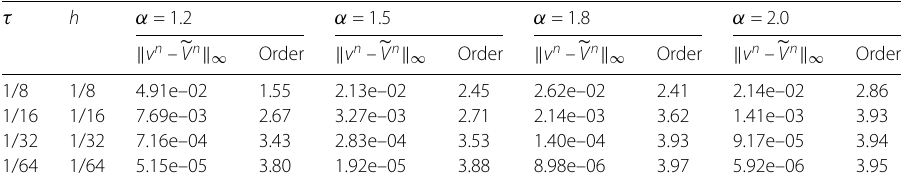
Table 4 L ∞ -norm errors and convergence orders of (cid:24) V obtained by the fourth-order scheme for Example